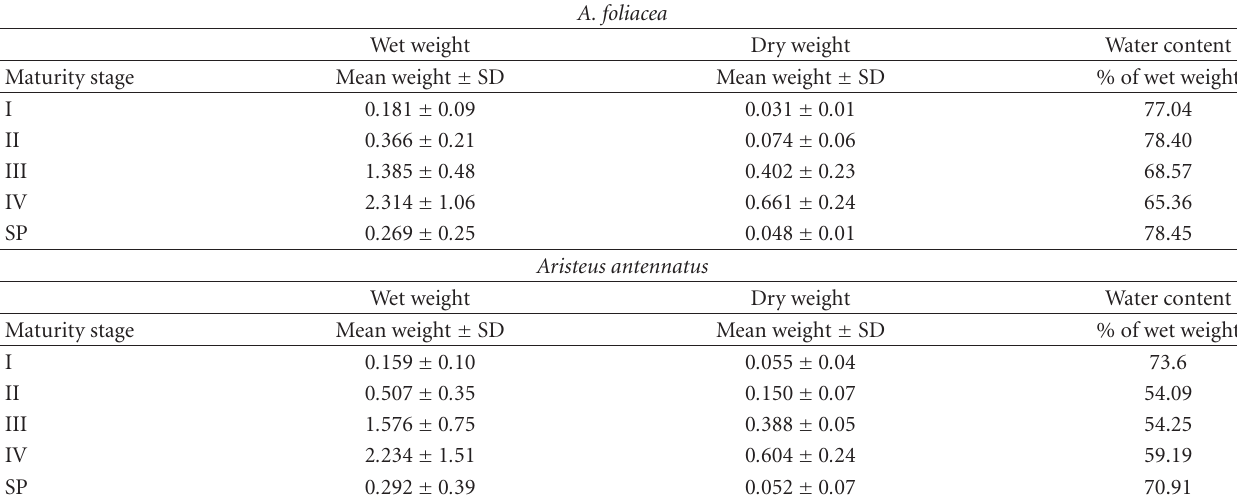
Table 2: Mean wet gonad weight, dry gonad weight (g), water content (% of wet gonad weight) and standard deviation ( ± SD) prematurity stage in A. foliacea and Aristeus antennatus females.